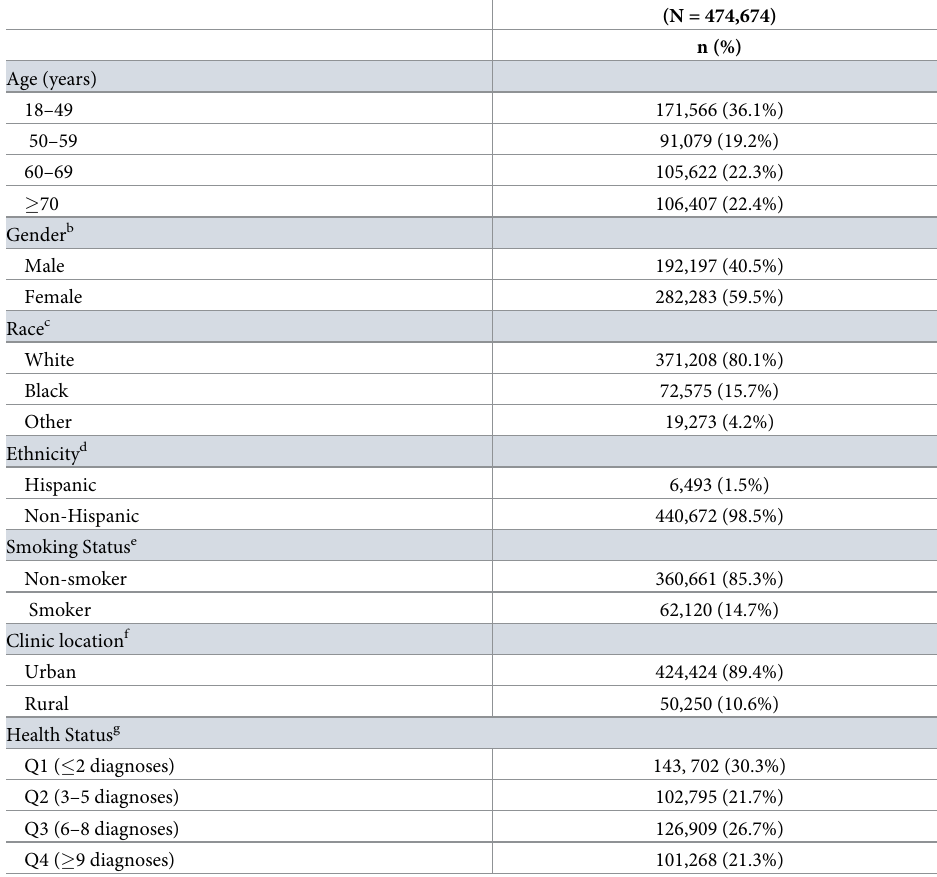
Table 1. Sample characteristics a